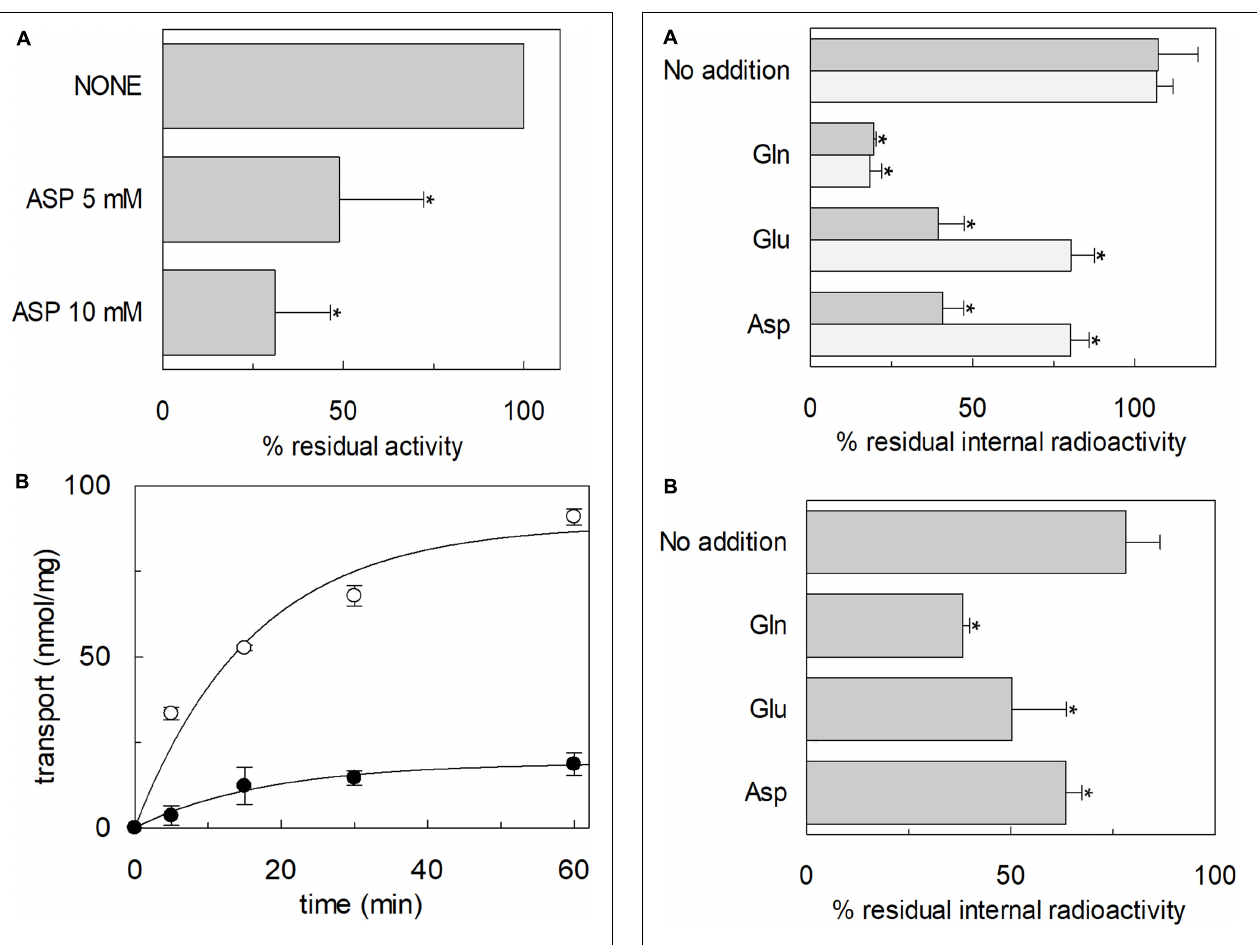
FIGURE 13 | Efflux of glutamine through hASCT2. In (A) [ 3 H]glutamine efflux from proteoliposomes. Purified hASCT2 was reconstituted in proteoliposomes containing 10 mM glutamine as described in materials and methods. The accumulation of radiolabeled glutamine was started by adding 50 µ M [ 3 H]glutamine in the presence of 50 mM Na-gluconate. After 60 min uptake, the [ 3 H]glutamine efflux was started in different conditions: no addition (control), the addition of 10 mM of glutamate or aspartate or 1 mM glutamine to the transport buffer in the presence of 50 mM Na-gluconate. The efflux was measured in 60 min using substrates buffered at pH 7.0 (light gray) or pH 6.0 (dark gray). In (B) , Efflux of [ 3 H]glutamine from HeLa intact cells. Cells were cultured as described in materials and methods; uptake was performed in 10 min adding 10 µ M [ 3 H]glutamine in the presence of 20 mM Tris–HCl pH 7.0 and 130 mM NaCl as described in materials and methods. The efflux was measured in 1 min in the presence of different conditions: no addition (control), the addition of 10 mM of glutamate or aspartate or 1 mM glutamine to the transport buffer constituted by 20 mM Tris–HCl pH 6.0 and 130 mM NaCl. Results are means ± SD from four independent experiments. *Significantly different from the control sample (no addition) as estimated by Student’s t -test ( P <